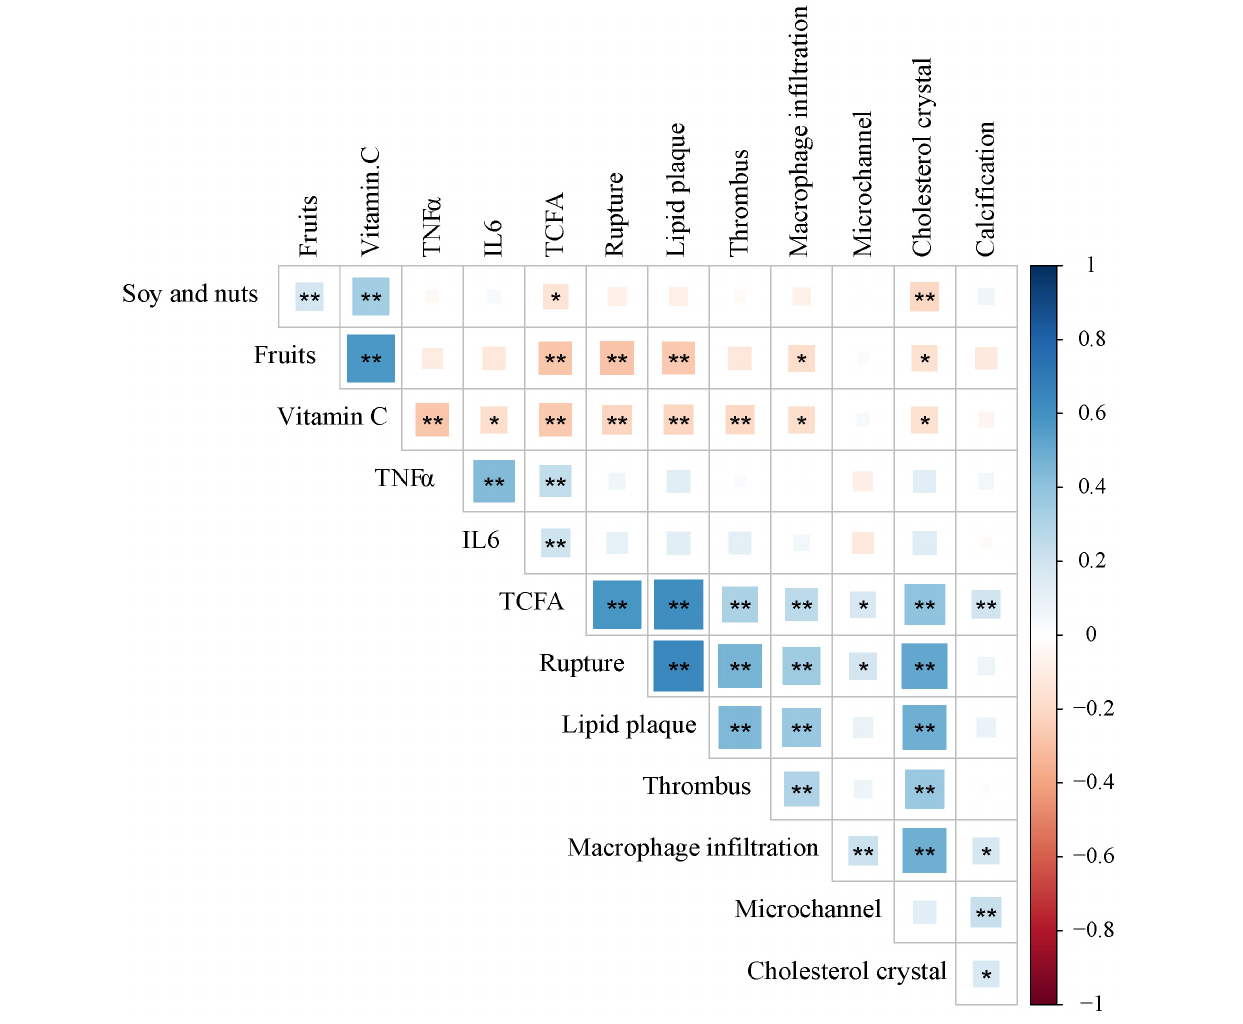
FIGURE 4 | Correlations between soy and nuts, fruits and Vitamin C nutrients, Inflammatory factors and Plaque characteristics. * p < 0.05; ** p < 0.01. TNF- α , tumor necrosis factor- α ; IL-6, interleukin-6; TCFA, thin cap